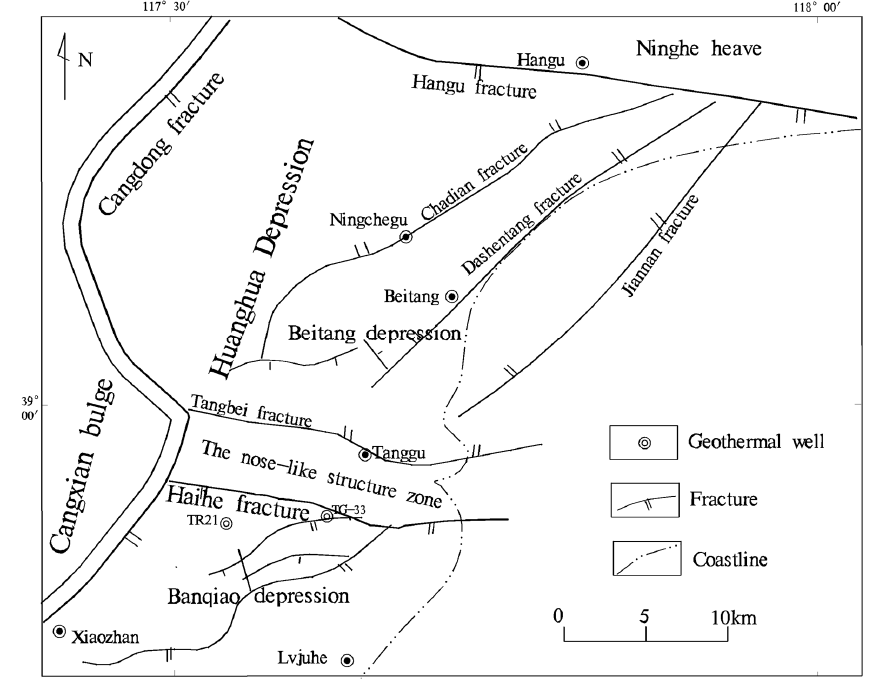
Figure 1. Geological structure characteristics of the study area.